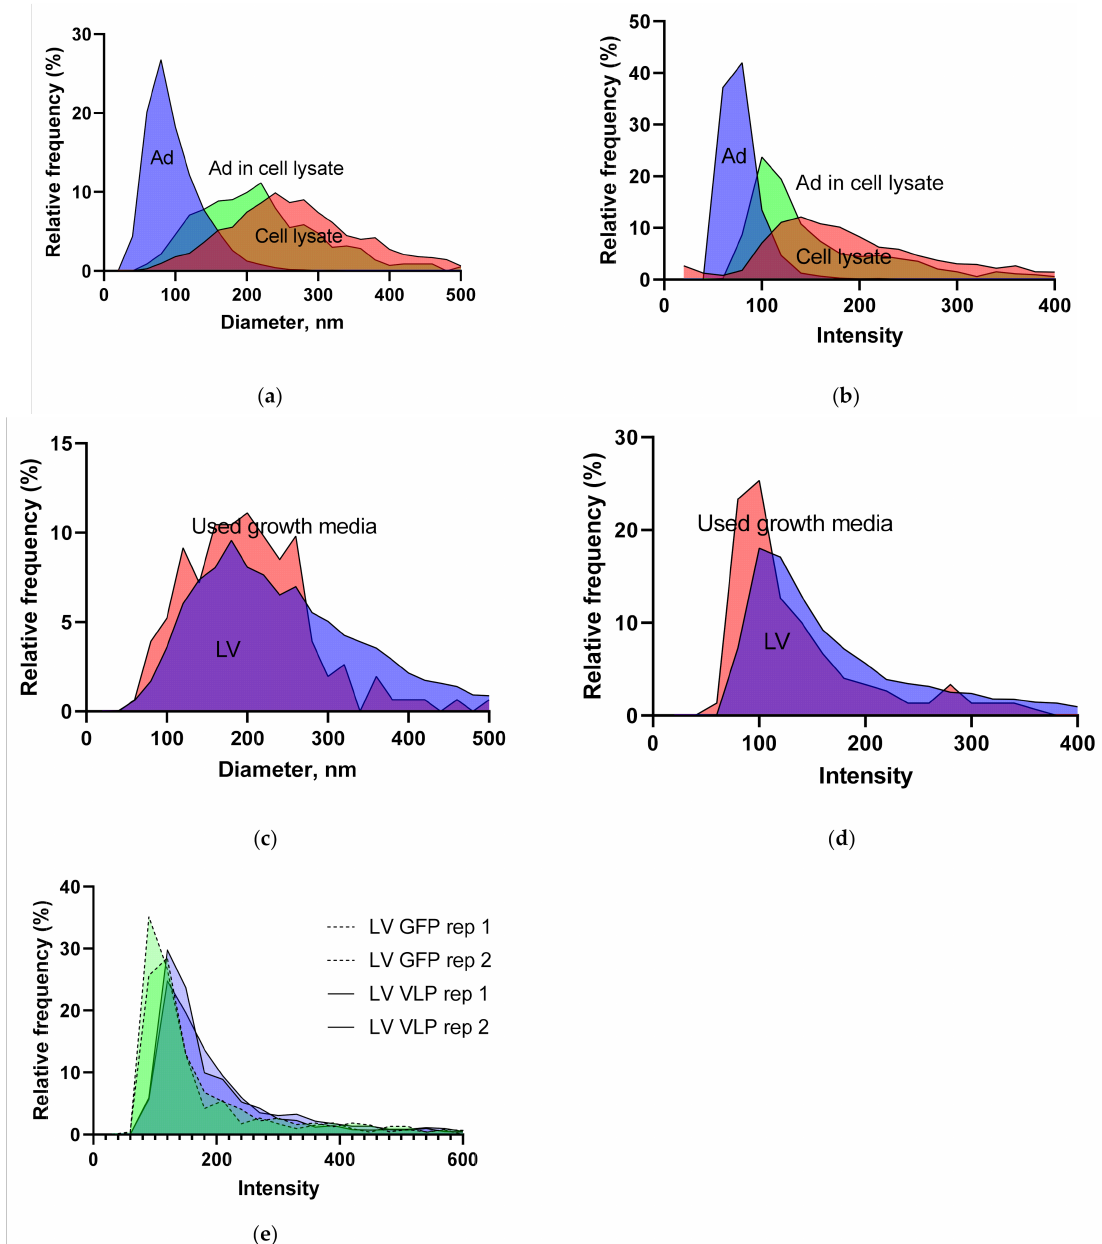
Figure 5. Intensity and diameter data from Ad and LV preparations (data pooled from several measurements), together with a common source of background signal. ( a ) Diameter of Ad, cell lysate and the two combined. ( b ) Intensity of Ad, cell lysate and the two combined. ( c ) Diameter of LV and used cell culture media. ( d ) Intensity of LV and used cell culture media. ( e ) Two different measurements of LV internal control (dotted line) and a LV VLP (empty LV, solid